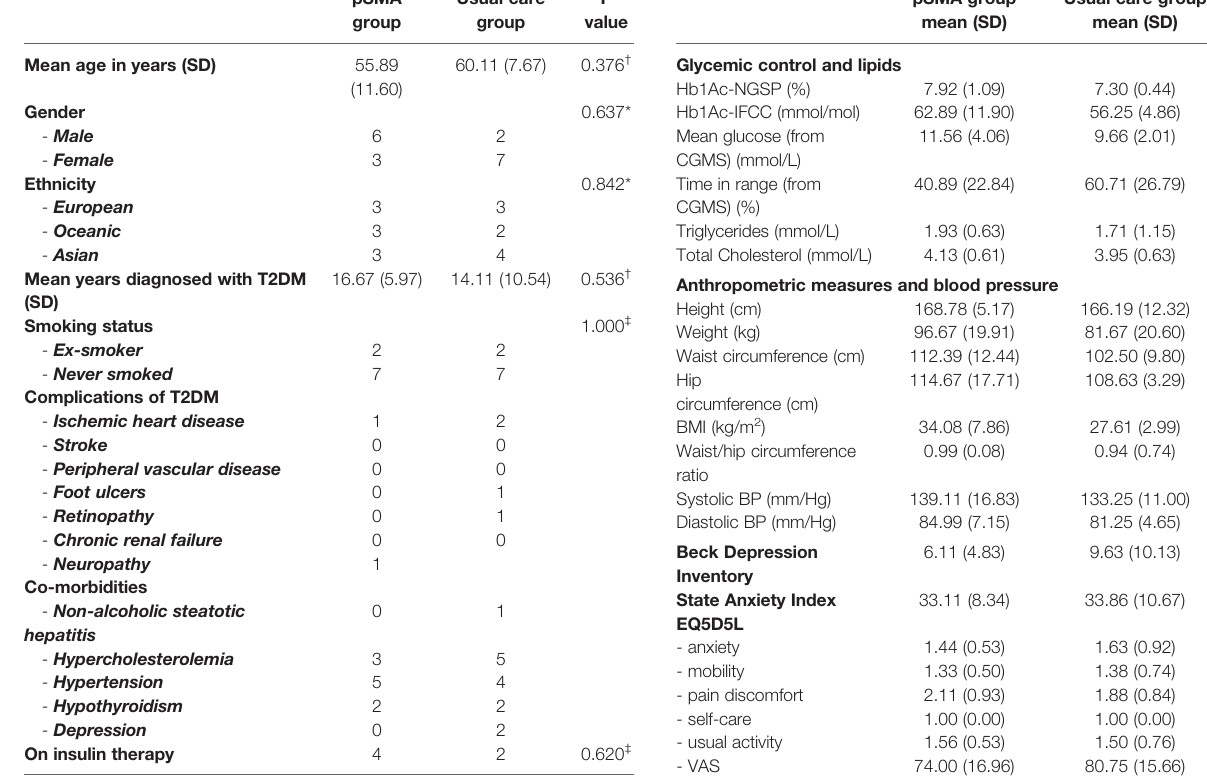
pSMA Usual care group group